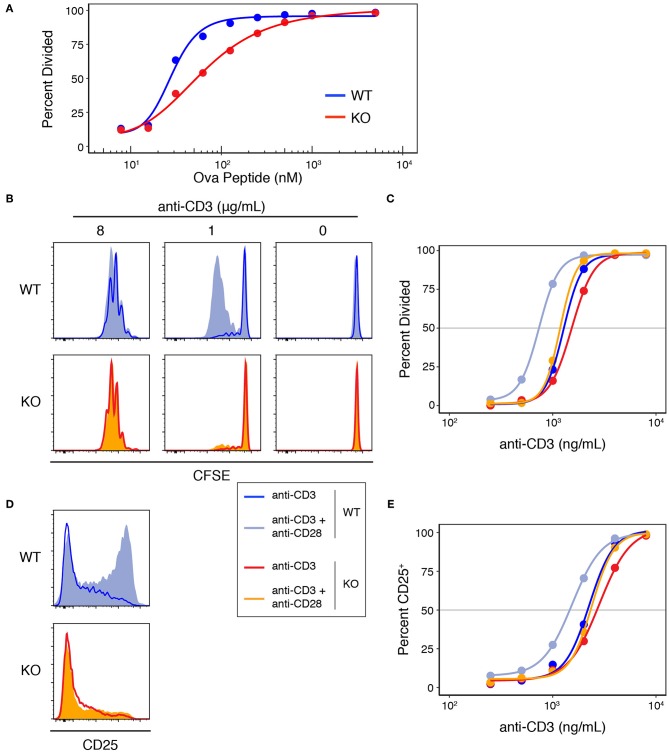
Add1 is required for CD28-mediated costimulation. (A) WT and Add1 KO OT-II CD4 T cells were labeled with CFSE and stimulated with LB27.4 B cells loaded with the indicated concentrations of Ova peptide. Cell division was measured on d3. (B) CFSE dilution of WT and KO CD4 T cells in response to the indicated concentrations of plate-bound anti-CD3 with or without soluble anti-CD28. Cell division was measured on d3. (C) Percent of cells that have divided at titrated doses of anti-CD3. (D) WT and Add1 KO OT-II CD4 T cells were stimulated with 2 μg/mL plate-bound anti-CD3 for 48 h and assayed for CD25 expression. (E) Percent of cells positive for CD25 at titrated doses of anti-CD3. Results are representative of >5 (A–C) or two experiments (D,E).